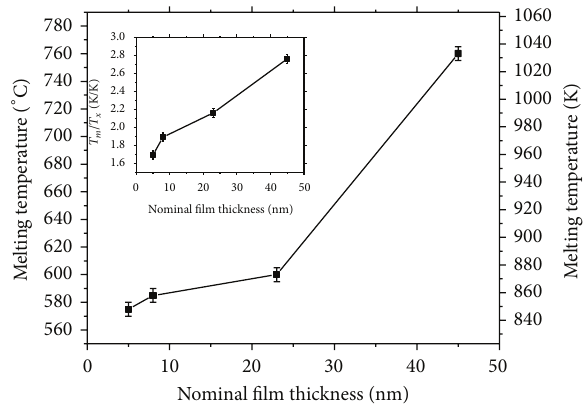
Figure 4: Melting temperature versus nominal film thickness of In 2 Se 3 in nanopit substrate. Inset shows the ratio of 𝑇 𝑚 /𝑇 𝑥